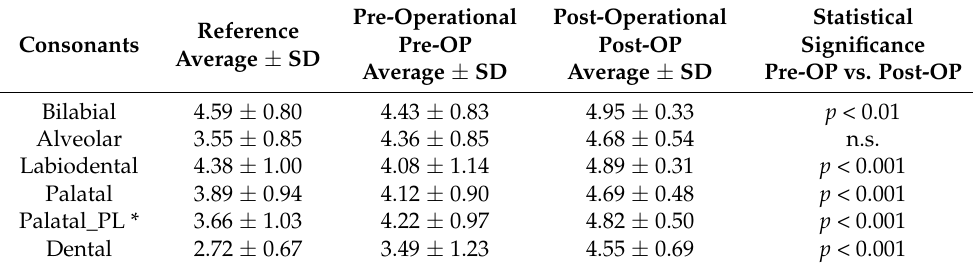
Table 6. Articulation before and after surgery divided into consonant groups according to the International Phonetic Alphabet revised to